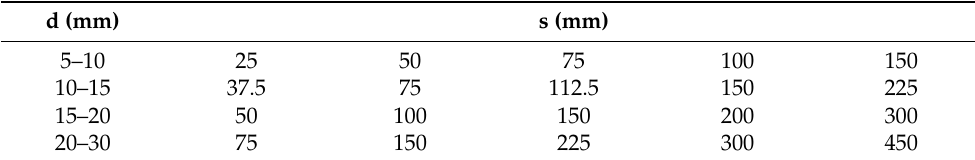
Figure 4. Attached roughness elements with d = 5–10 mm, s = 5 d: ( a ) design; ( b ) experiment setup. Table 1. Different scenarios for model design.